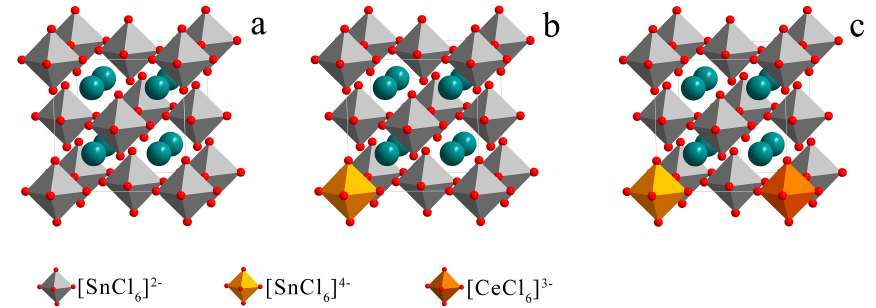
Figure 6. ( a ) The Cs 2 SnCl 6 crystal structure; ( b ) The Cs 2 SnCl 6 crystal structure containing [SnCl 6 ] 2 − ; ( c ) The Cs 2 SnCl 6 crystal structure containing [SnCl 6 ] 4 − and [CeCl 6 ] 3 − .